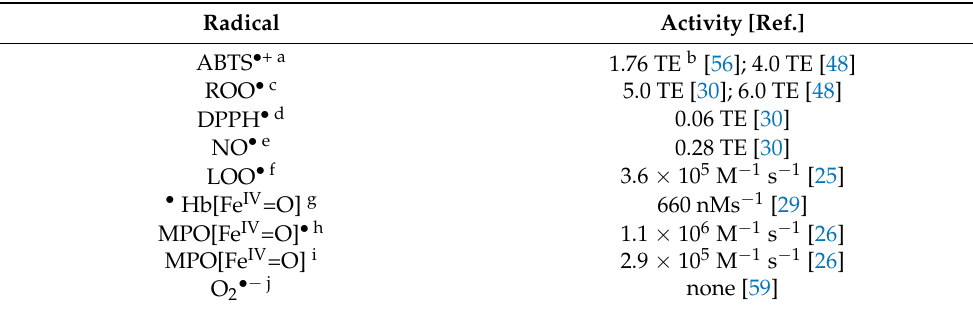
Table 1. Radical scavenging activity of